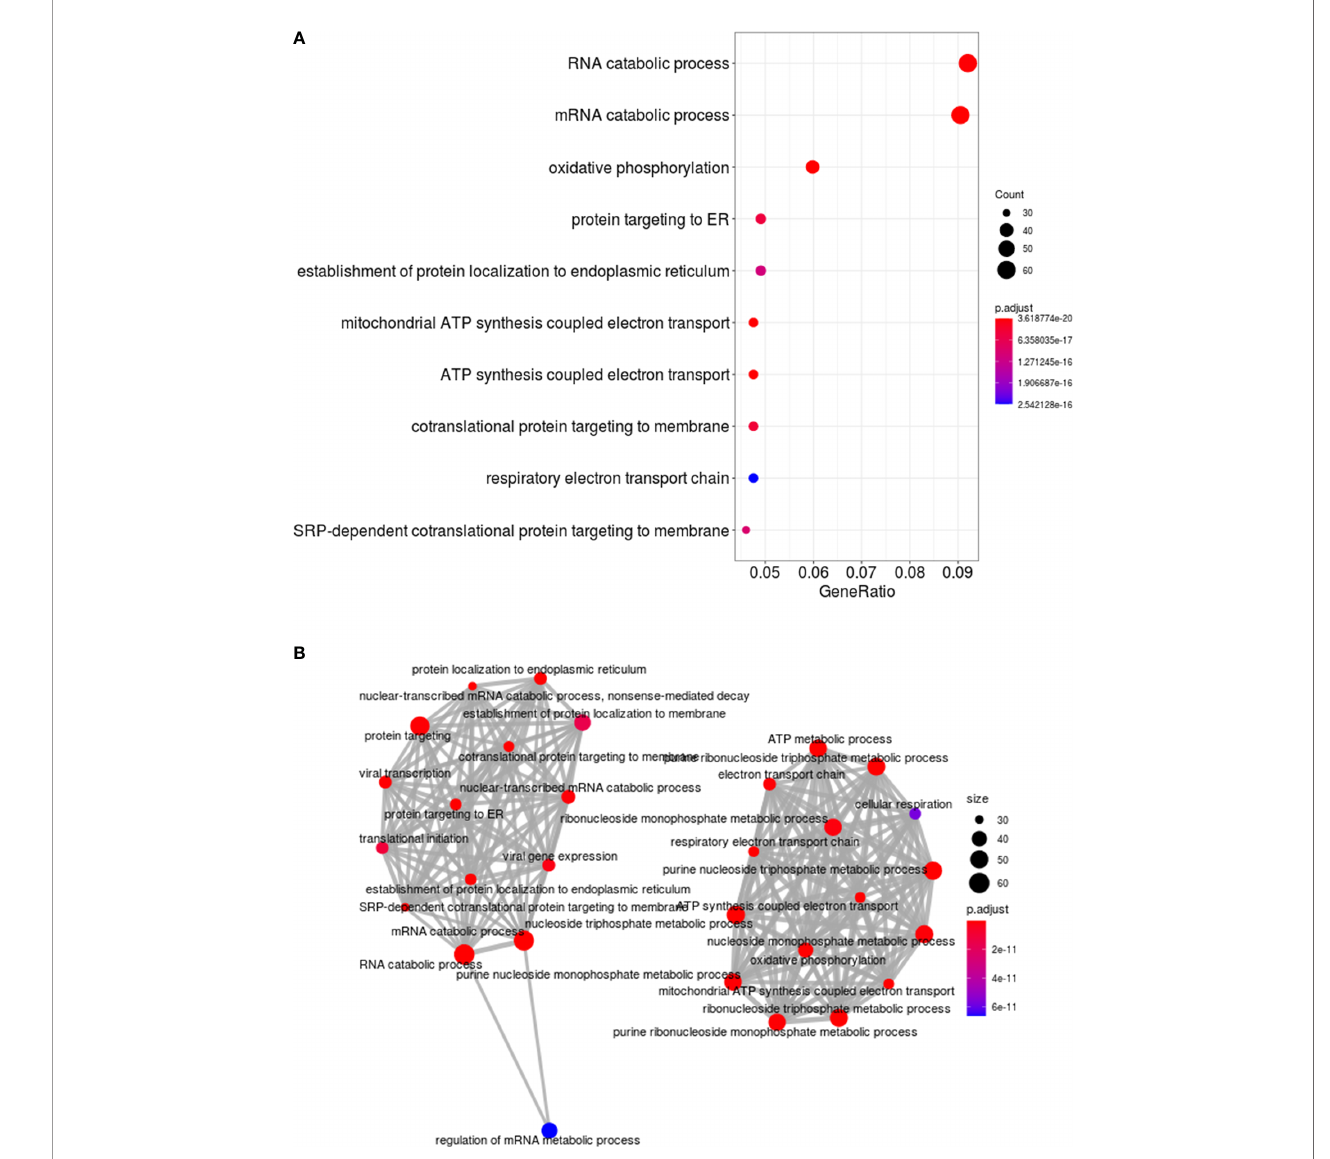
FIGURE 3 | Functional enrichment analysis of DEGs in cervical cancer stem-like cells from Non-Responder (n=10) compared to Responder patients (n=21). (A) The top ten Biological process GO terms signi fi cantly enriched from clusterPro fi ler analysis of the 1050 DEGs. The dots are colored by the statistical signi fi cance of a GO term (lowest to highest p-values), and size represents the ratio of genes associated with the GO term and the total number of genes. (B) Enrichment map of the most signi fi cantly enriched Biological process terms. The GO terms are depicted as nodes, connected by overlapping gene sets. The node color and size correspond to statistical signi fi cance of a GO term enrichment and the number of genes in the set,